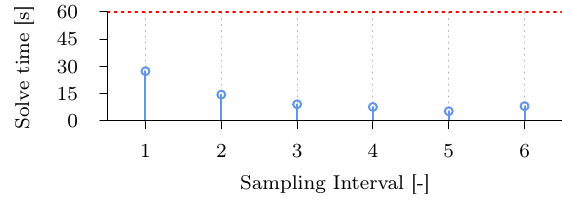
Figure 8: The computation time of each optimization problem is always less than 30 s. This gives the operator enough time to upload the new waypoints within the sampling period of 60 s.